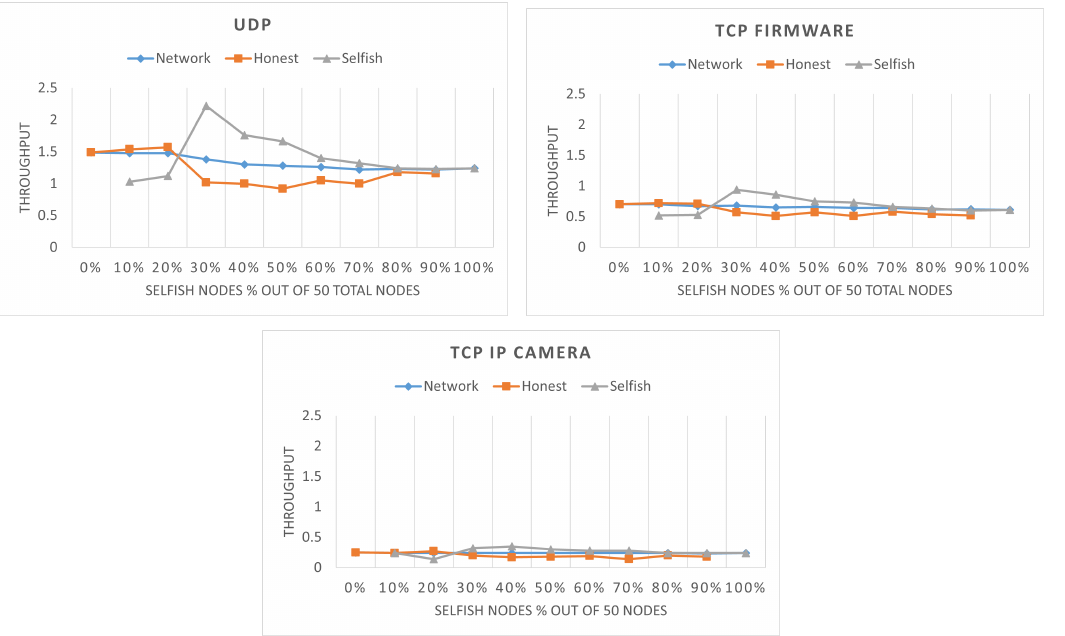
Figure 6. Network throughput (in Mbps) of the network, selfish, and honest stations in 60 s for different percentages of selfish stations in a network with two RAW